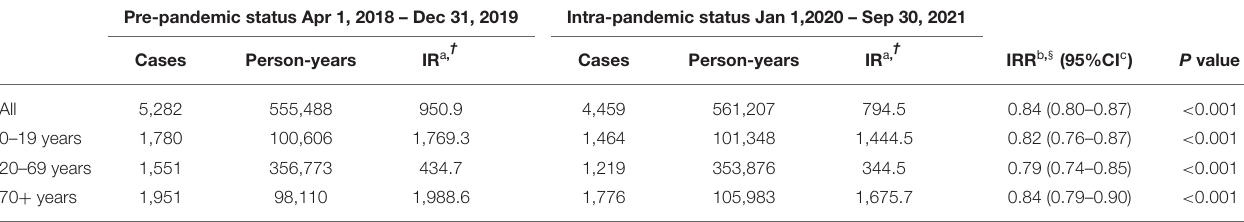
TABLE 1 | Incidence of head trauma according to pre- and intra-pandemic status in Akashi city, Japan.